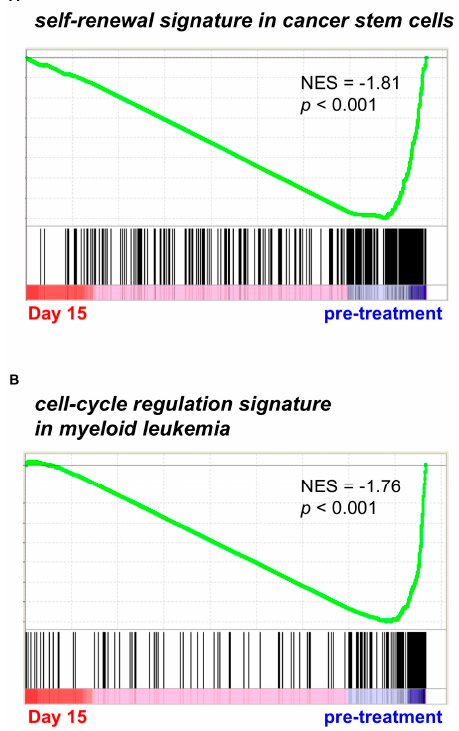
Figure 1. PF-913 treatment of clinical AML patients commonly affected self-renewal and cell-cycle statuses Gene Set Enrichment Analysis (GSEA) showed that ( A ) the self-renewal signature was highly modulated during PF-913 treatment in one AML patient, while ( B ) the cell-cycle signature was modulated in all patients. NES: normalized enrichment scores.